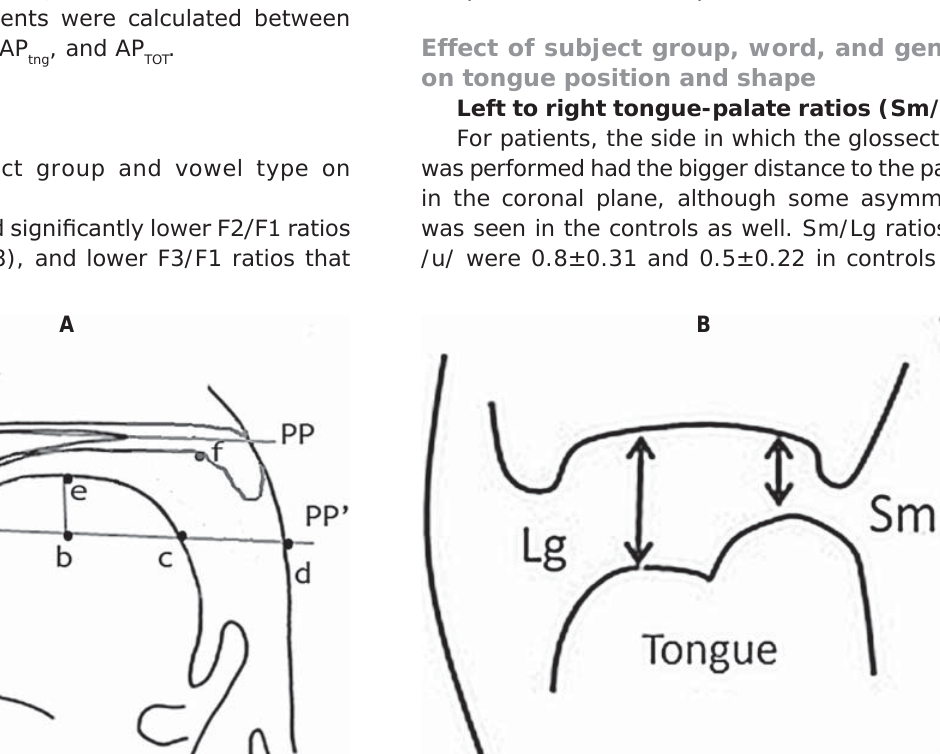
Figure 3- Landmarks in (A) the midsagittal plane and (B) the coronal plane at the second molar. Landmarks are based on the palatal plane (PP) and a line parallel to PP intersecting tongue tip (PP’). Tissue points used as landmarks include of tongue on the PP’ line (c), the intersection point of the pharynx with the PP’ line (d), the most upper point of tongue